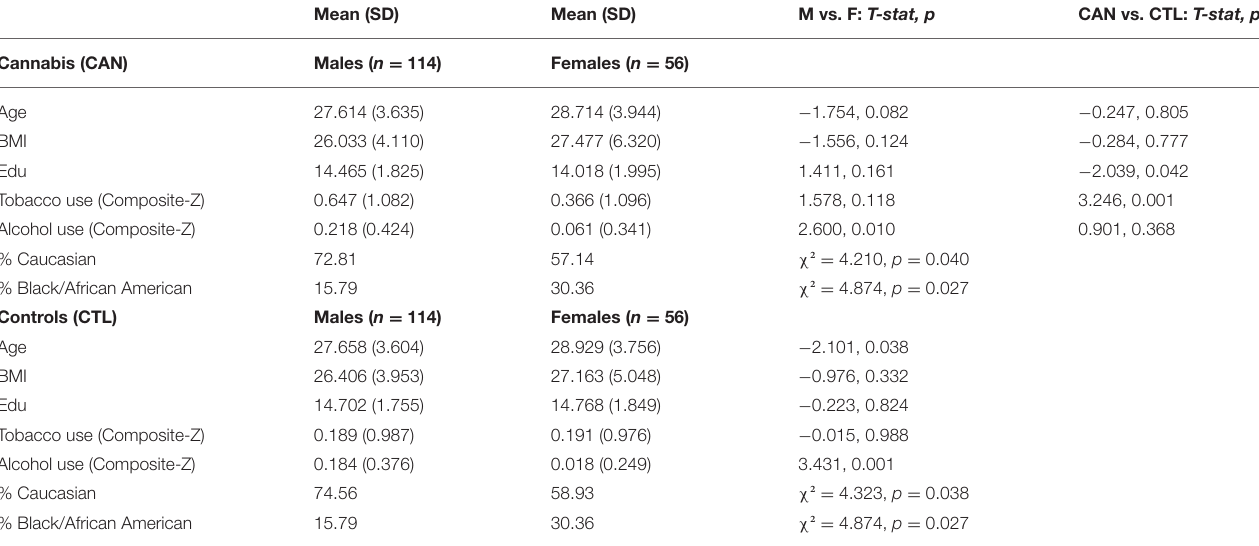
TABLE 1 | Demographics and clinical characteristics for chronic cannabis users (CAN) and controls (CTL). Mean (SD) Mean (SD) M vs. F: T-stat, p CAN vs. CTL: T-stat,